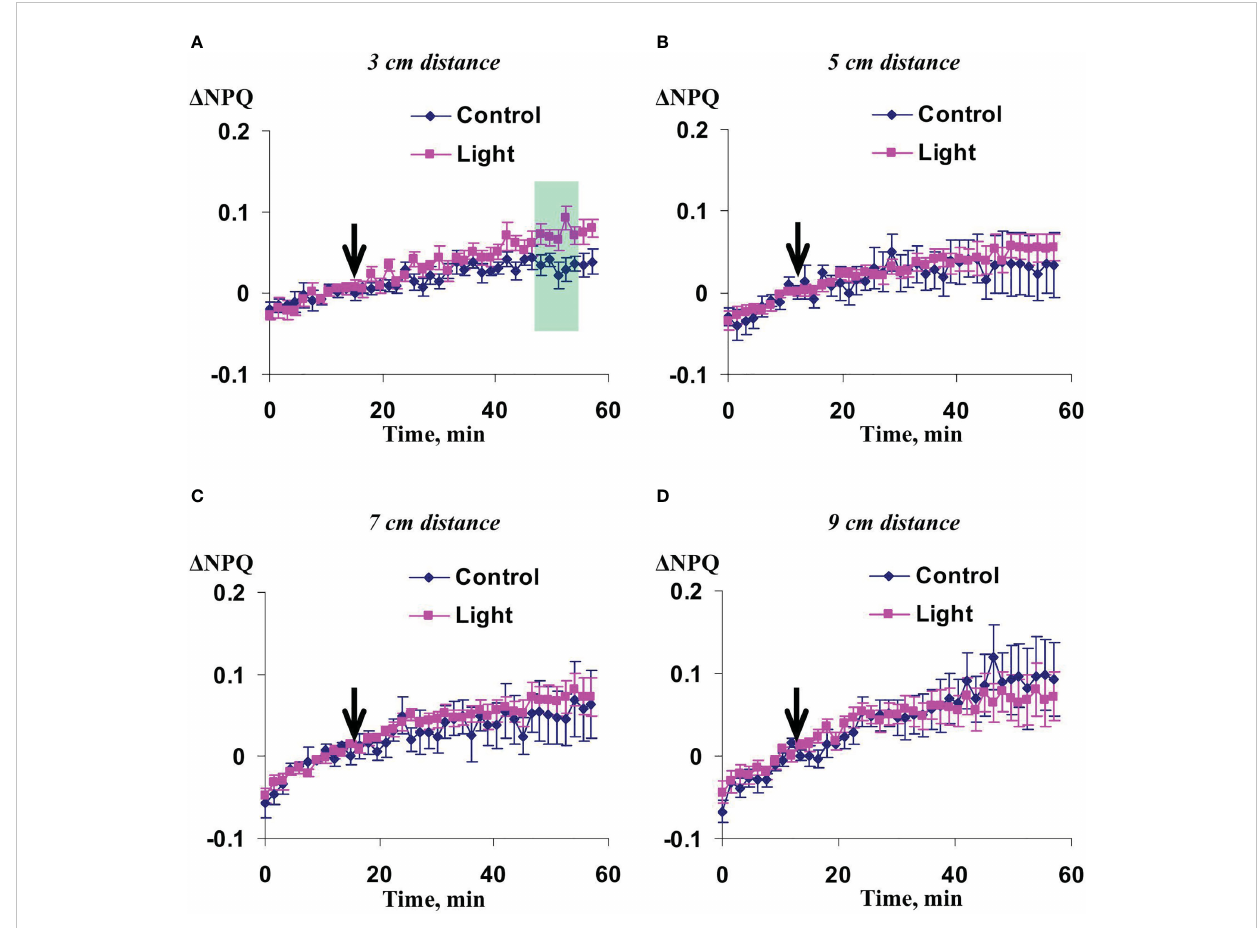
FIGURE 11 Averaged changes in the non-photochemical quenching of chlorophyll ( D NPQ) in 3 cm (A) , 5 cm (B) , 7 cm (C) , and 9 cm (D) from zone of the local action of blue light in irrigated wheat plants ( n =8). Arrow marks initiation of this action; control plants were not irritated. D NPQ was calculated as NPQ - NPQ 0 , where NPQ 0 was measured before the initiation of the irritation. Intensity of the white actinic light was 456 µmol m -2 s -1 . Green shading shows time interval with signi fi cant differences between experimental and control values ( p <0.05, Student ’ s